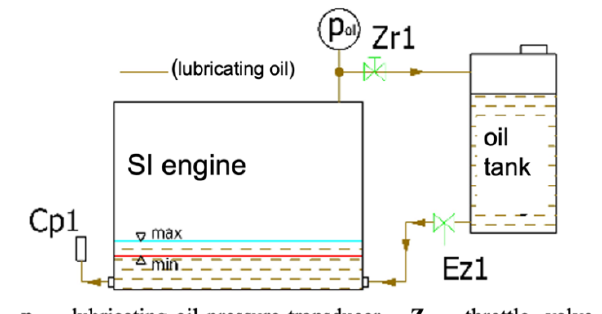
Fig. 3. Scheme of the engine lubricating oil refilling system The prototype engine oil pan is a part of the engine block cast, there are two stub pipes with factory-blinded screws on its opposite side surfaces. The mentioned stub pipes were used to connect the oil dosing system. The measurement of the engine oil level system is mounted to the stub on the drive side of the engine. In turn, an oil res- ervoir is connected to the stub on the other side of the en- Fig. 2. Scheme of the heat collection system from the internal combustion engine